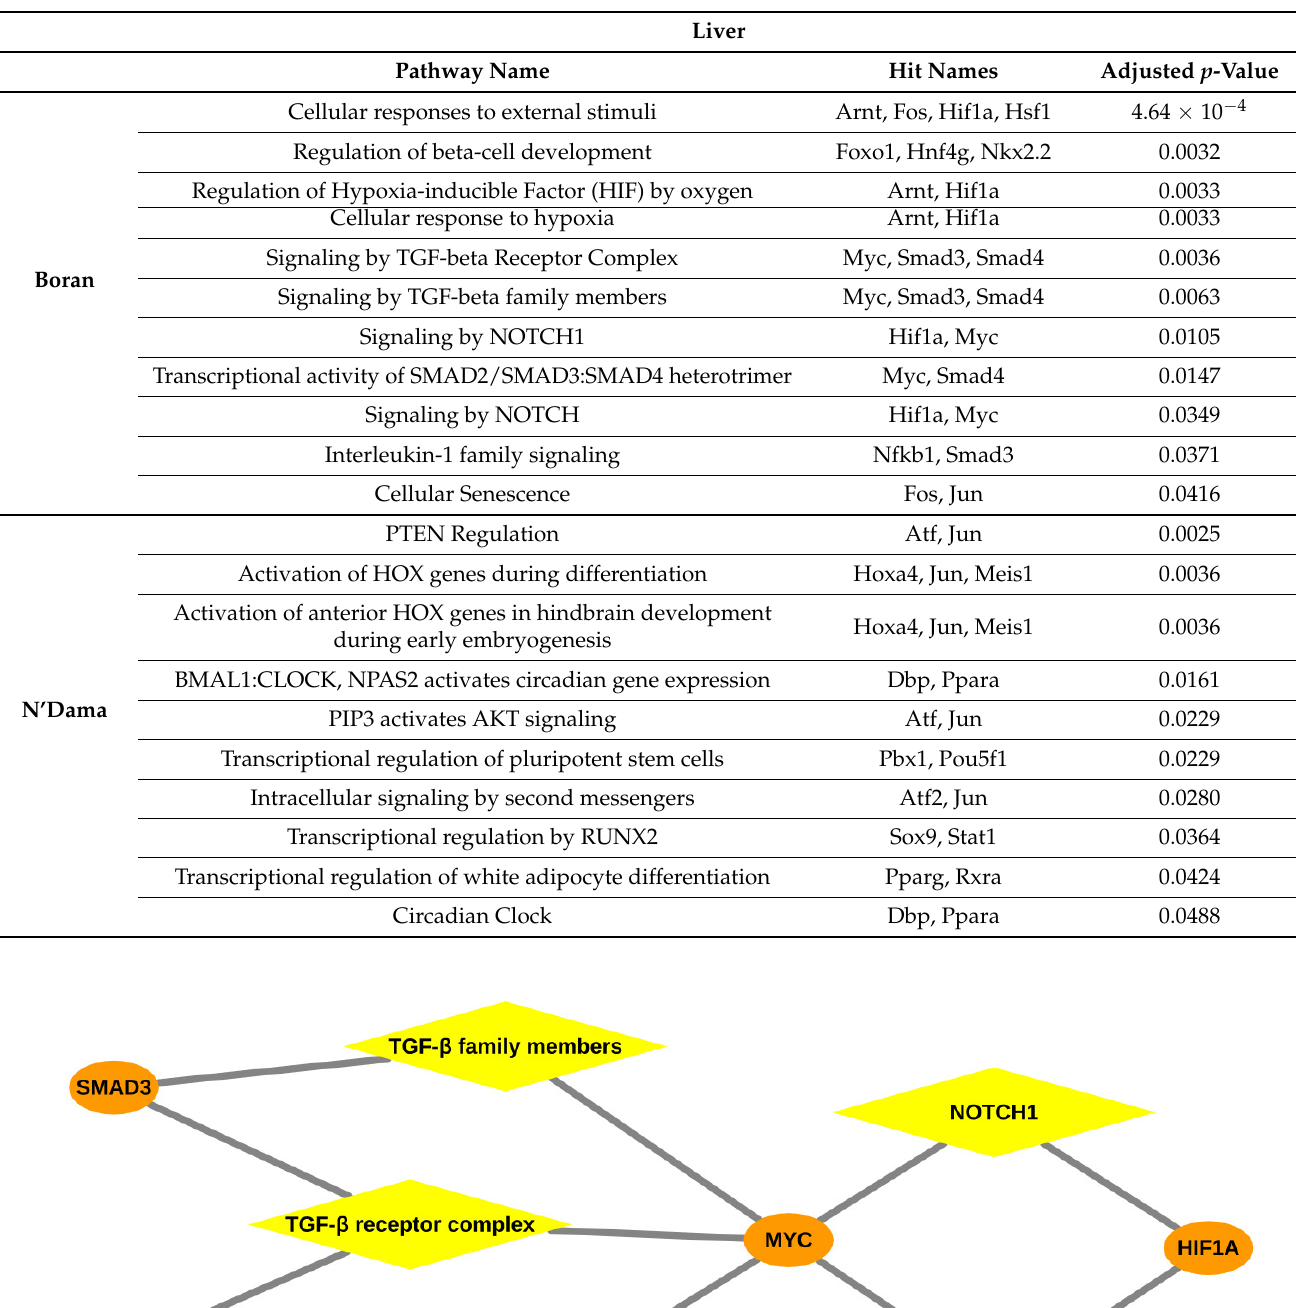
Table 3. Significantly over-represented pathways found for the liver tissue of Boran and N’Dama ( p -adjusted < 0.05).